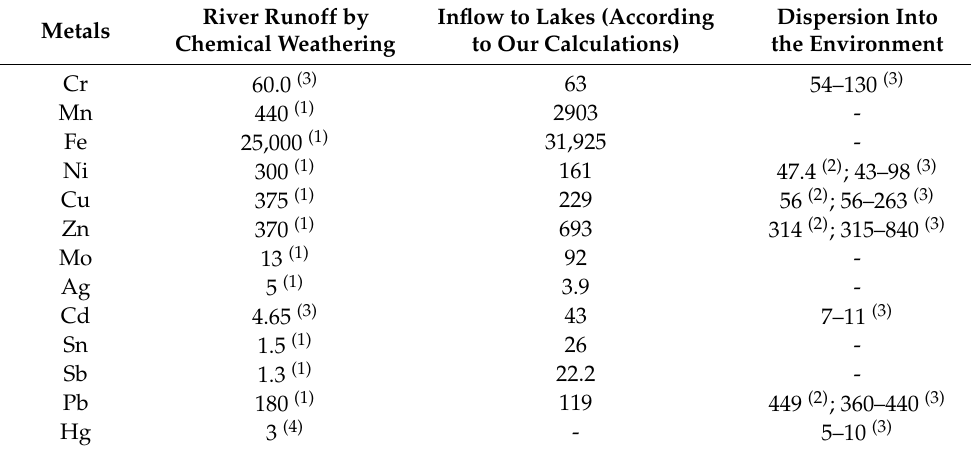
Table 2. Natural runoff of metals with rivers and anthropogenic input of elements into the envi- ronment and lakes, including metals (according to estimates by various authors: (1)—Bryan